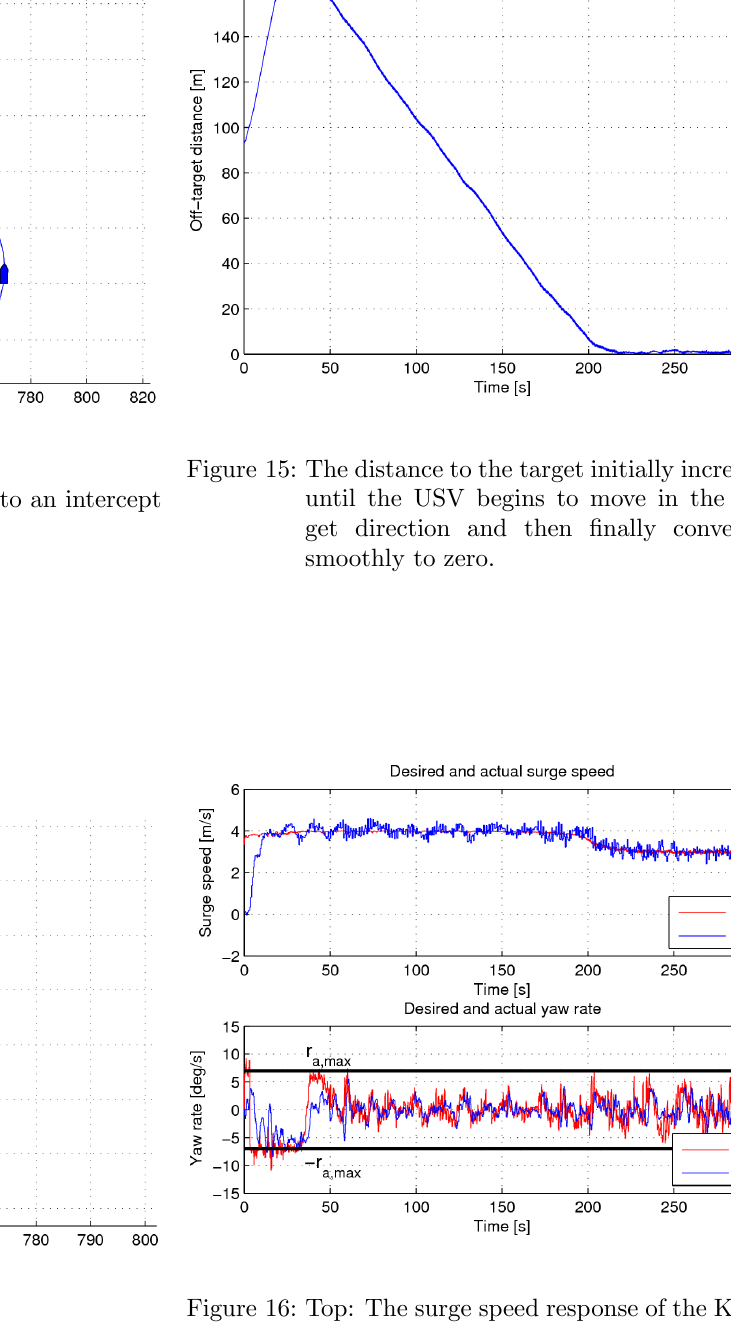
Figure 14: The USV has intercepted the target.